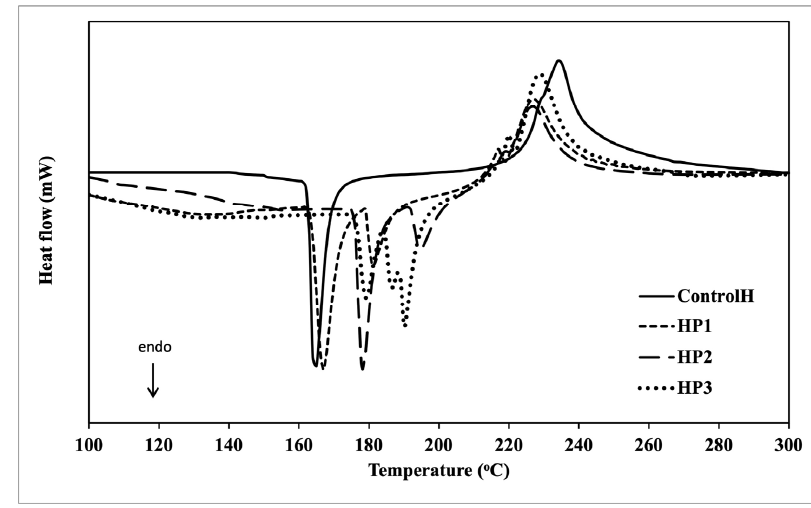
Figure 4. DSC thermograms of hyaluronic films with propolis.